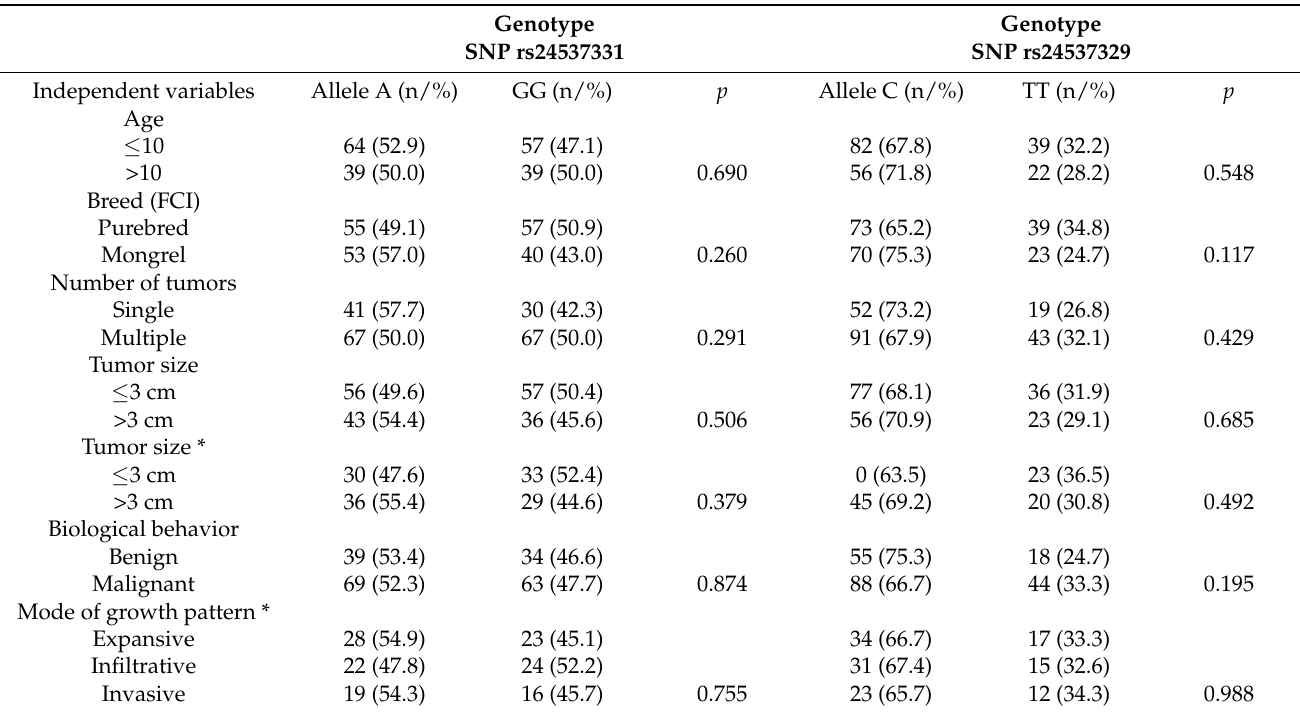
Table 2. Association between SNP rs24537331 (GG/A allele carriers) and SNP rs24537329 (TT/C allele carriers) in HER2 gene with clinicopathological variables of canine mammary